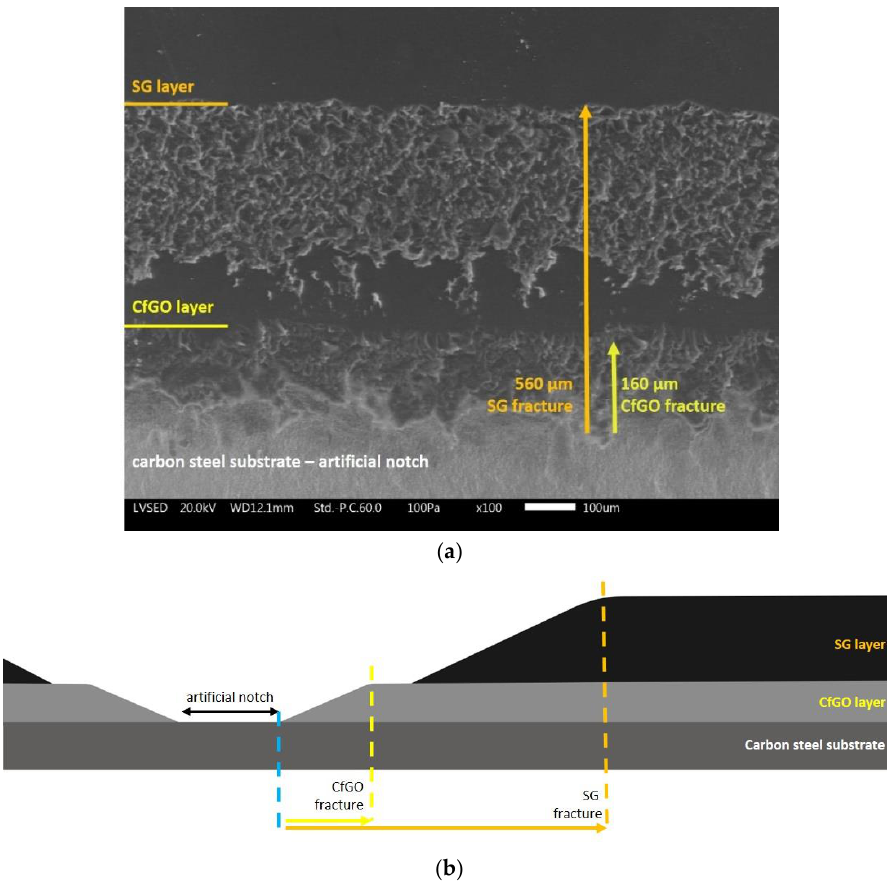
Figure 8. Top view of coating fracture in sample CfGO-SG, observed by SEM ( a ) and the schematic cross section of the system ( b ).